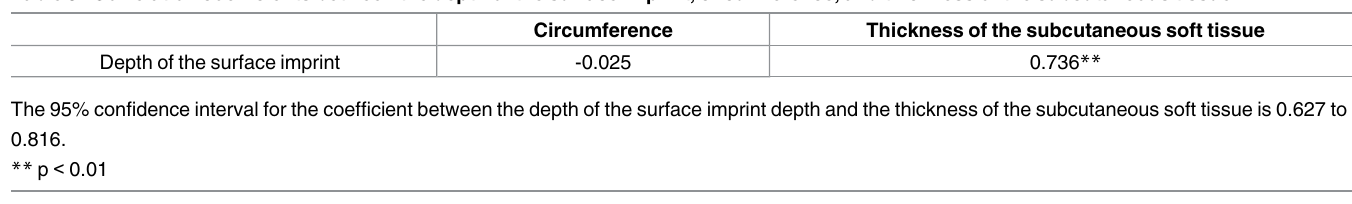
Table 3. Correlation coefficients between the depth of the surface imprint, circumference, and thickness of the subcutaneous